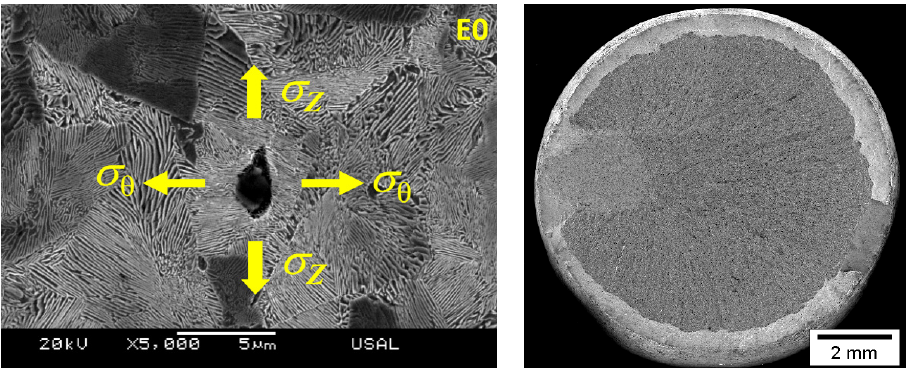
Figure 18. Anisotropic fracture behavior in a cold drawn pearlitic steel (E7).